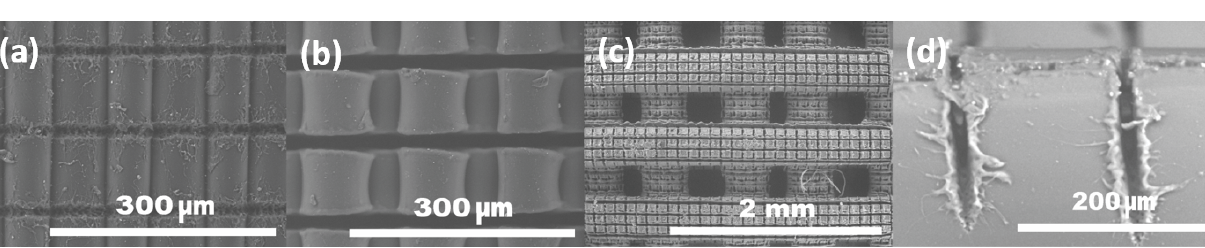
conditions: ( a , b ) sheet and ( c , d ) log-/wood-pile structure at different magnifications, front and side views,